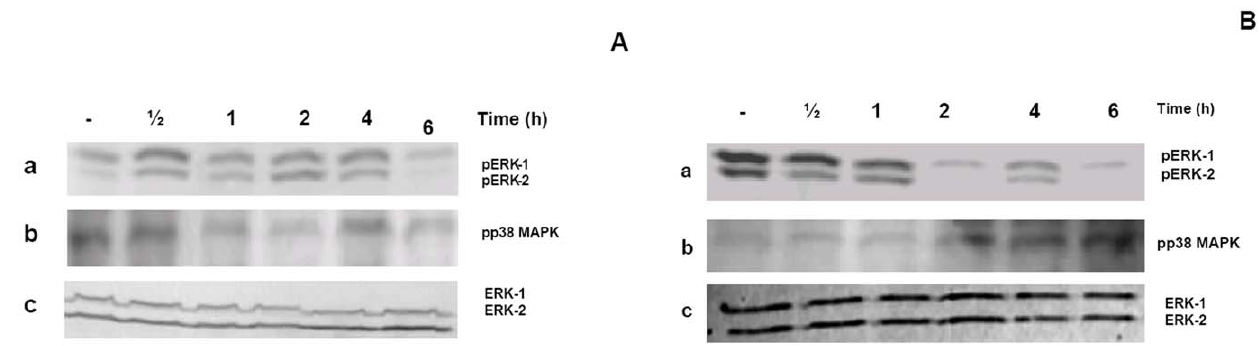
Figure 5. Effect of Berberine chloride on MAPK pathway in macrophages. A: A representative profile of uninfected macrophages was treated with Berberine chloride (10 m M) for 30 min-6 h. The cells were lysed and subjected to Western blotting with anti-pERK1/2 (a), anti-pp38 MAPK (b) and anti-ERK1/2 (c) as described in Methods. B: A representative profile of Leishmania infected macrophages were treated with Berberine chloride (10 m M) for 30 min-6 h. The cells were lysed and subjected to western blotting with anti-pERK1/2 (a), anti-pp38 MAPK (b) and anti-ERK1/2 (c) as described in Methods.